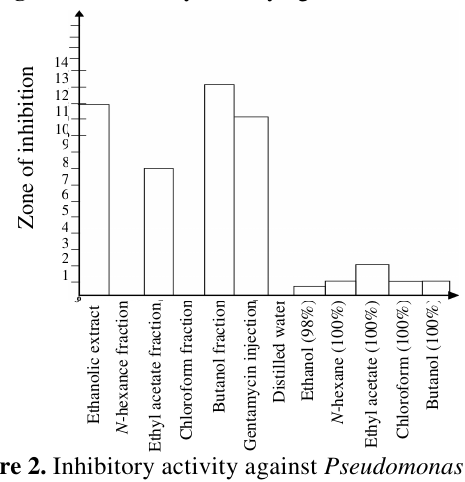
Figure 1 . Inhibitory activity against Escherichia coli .